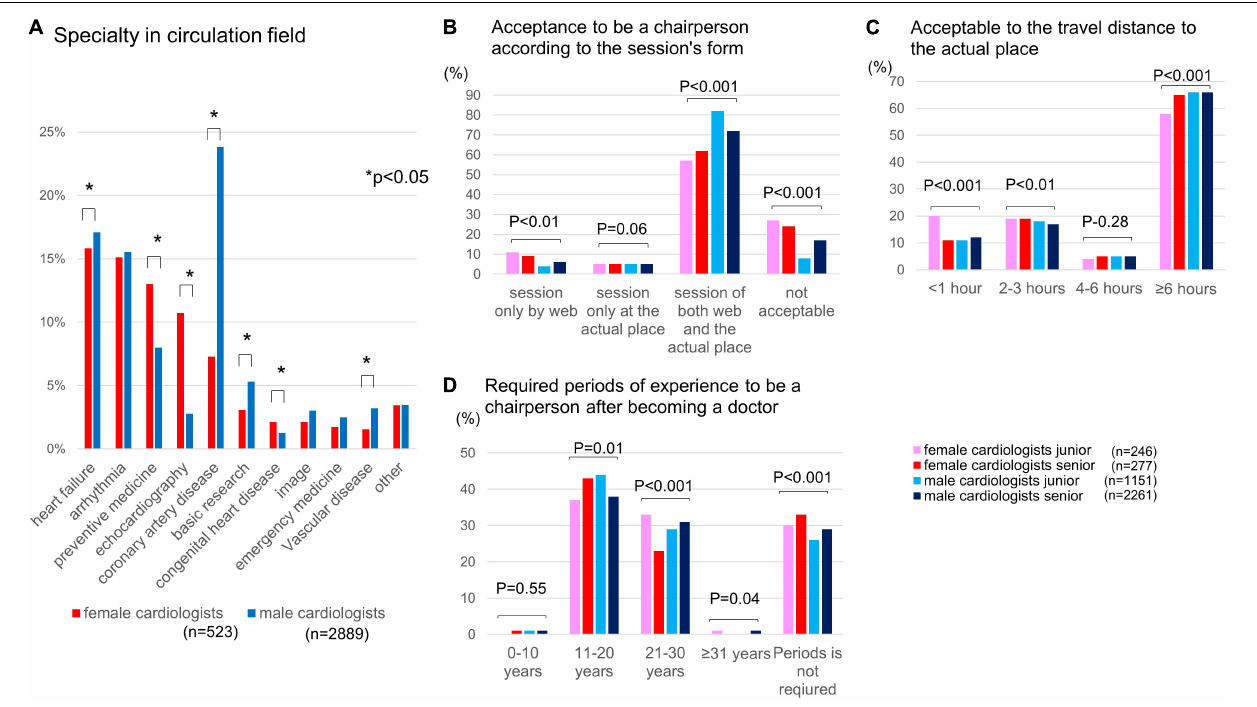
FIGURE 2 | Specialty of cardiologists in Japan, awareness of chair acceptance for scientific meetings, and changes in the rates of female cardiologists. (A) Background of cardiologist specialties in the cardiovascular field. (B) Chair acceptance for scientific meetings. (C) Chair acceptance based on travel distance to the meeting. (D) Experience required to be a chairperson (years). * p < 0.01.